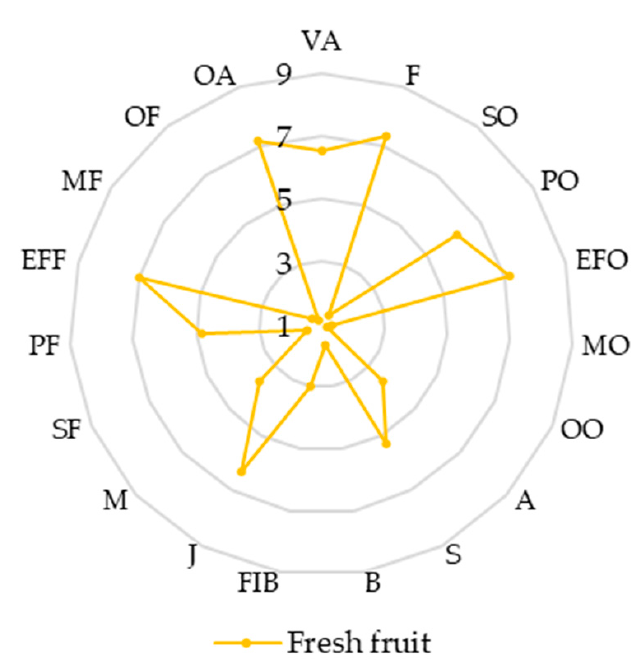
Figure 7. Sensory analyses of fresh-cut mango cubes after cutting. Descriptors: visual appearance (VA), firmness (F), sea odour (SO), peach odour (PO), exotic fruit odour (EFO), medicinal odour (MO), off-odour (OO), acidity (A), sweetness (J), bitterness (B), fibrousness (FIB), juiciness (J), mellowness (M), sea flavour (SF), peach flavour (PF), exotic fruit flavour (EFF), medicinal flavour (MF), off-flavour (OF), overall assessment (OA).